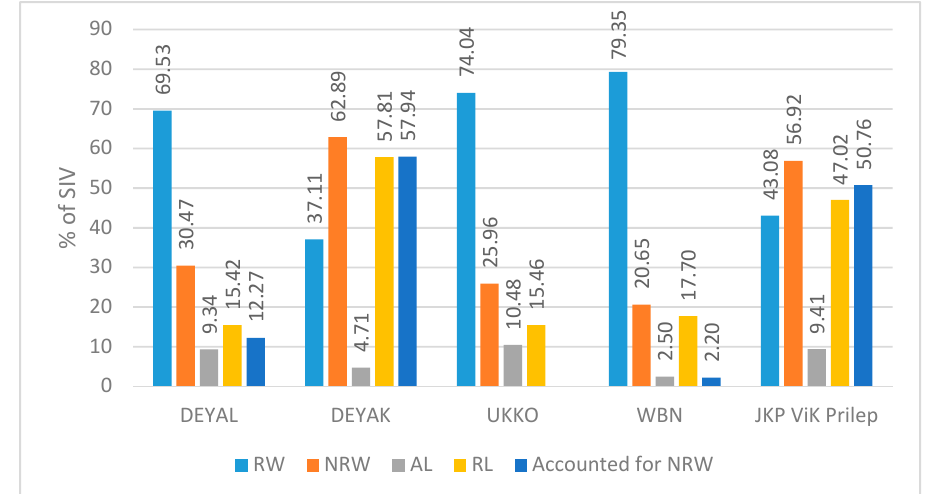
Figure 3. WB components estimated for all water utilities in % of